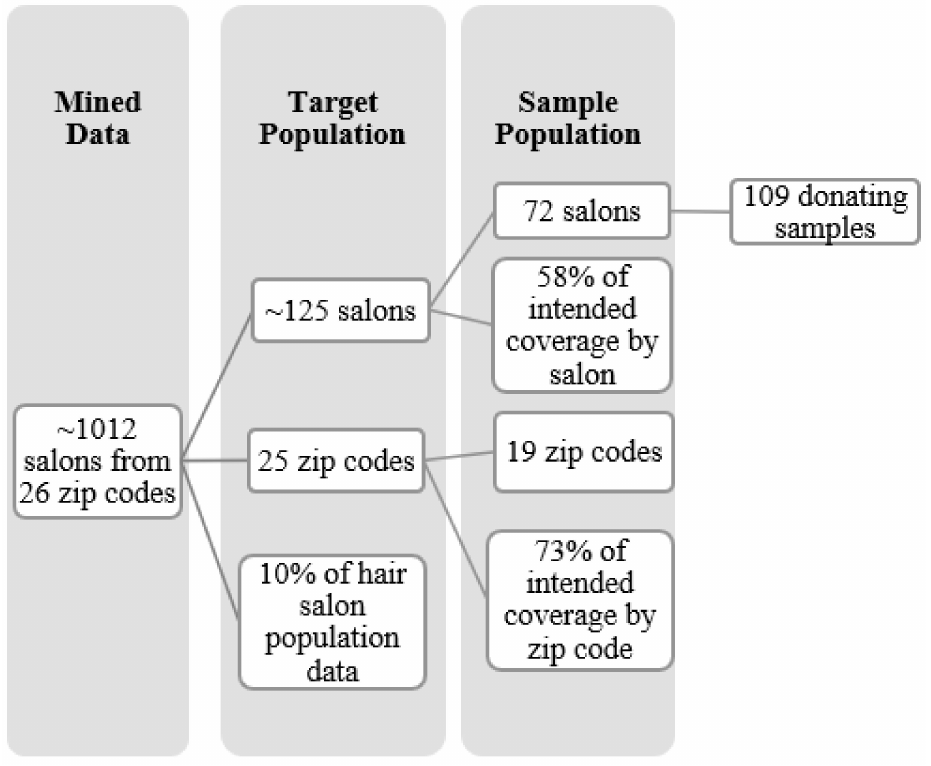
Figure 1. Sampling plan for selecting hair salons by zip